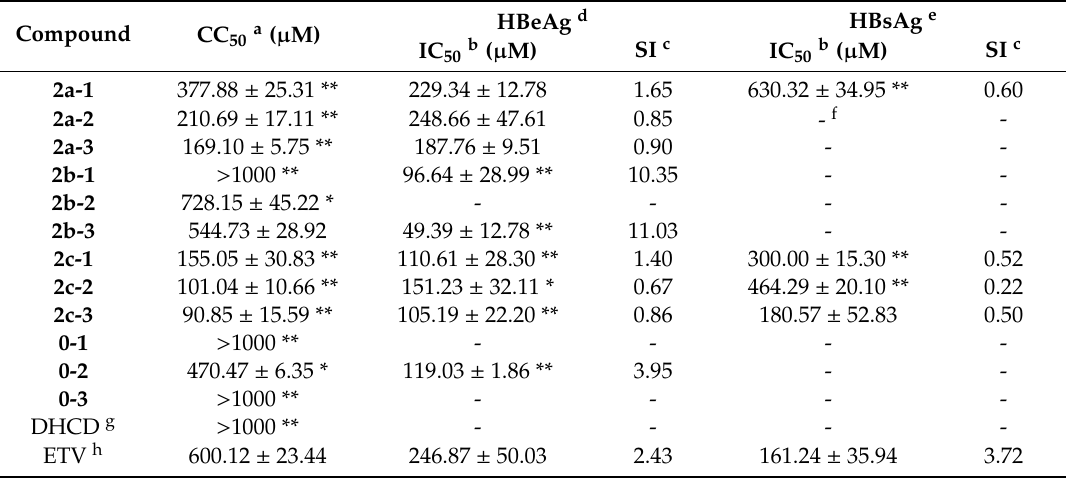
Table 1. Cytotoxicity and inhibitory effect of target compounds on HBeAg and HBsAg in vitro . Compound